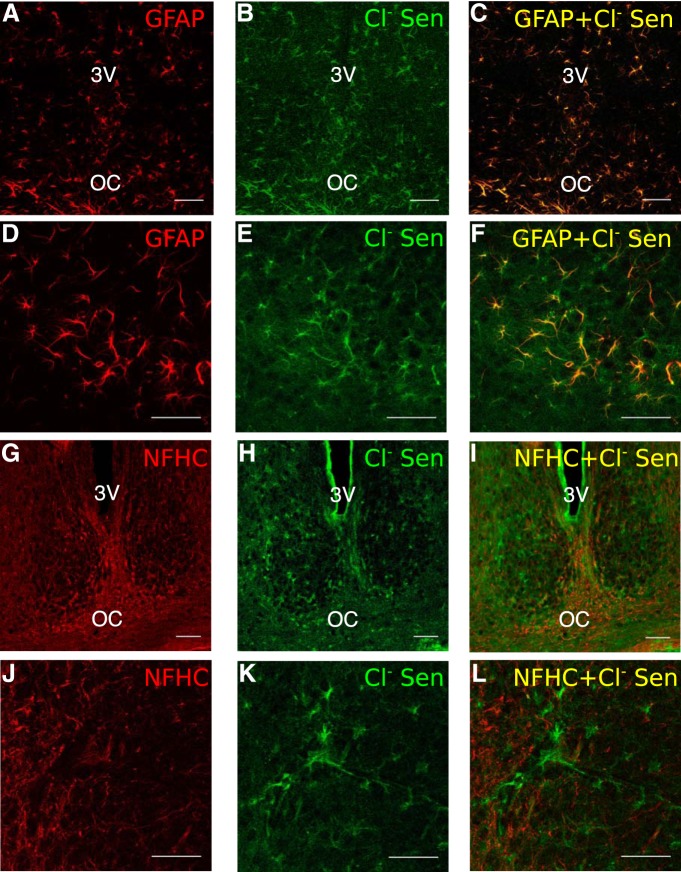
Chloride sensor expression in GFAP-Cre+ animals is specific to GFAP expressing astrocytes and not neurons or glial precursor cells. A–F, GFAP labeling (left), Cl sensor YFP fluorescence (center), and colocalization (right) within the SCN of GFAP-Cre+/Cl sensor+ animals. G–L, NFHC neuronal marker (left), Cl sensor YFP (center), and lack of colocalization (right) within the SCN. Scale bars are all 50 μm, images A–C and G–I were taken at 20× and images D–F and J–L were taken at 40×.